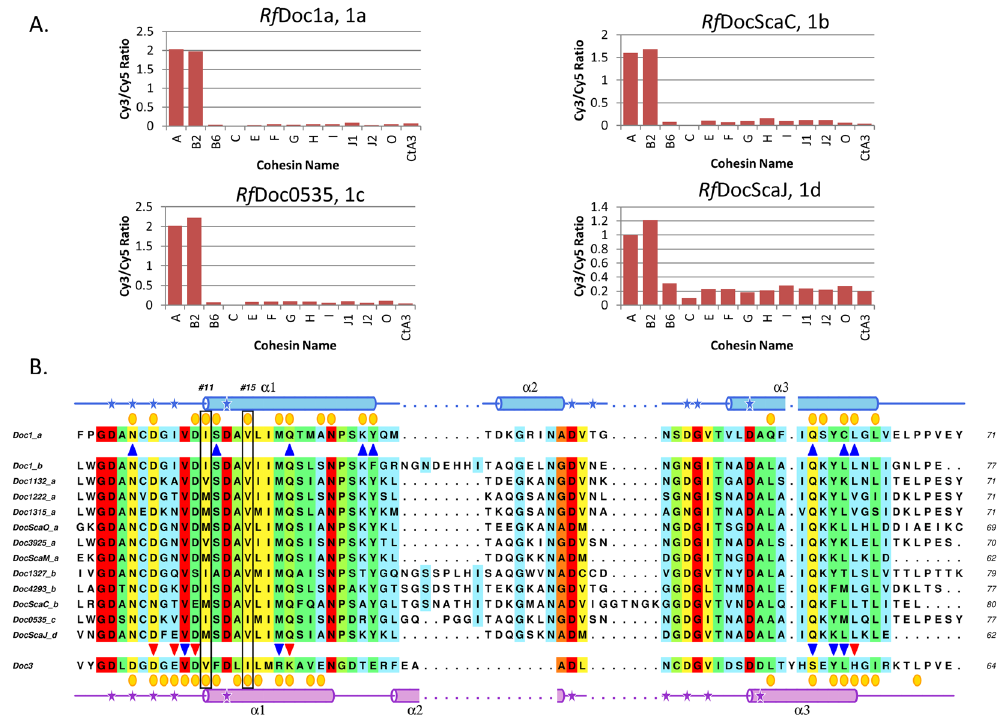
Figure 5. Coh-binding range and multiple sequence alignment of R . flavefaciens group 1 dockerins. ( A ) Results of Coh-Doc interactions using a cellulose microarray assay with XynDoc/CBM-Coh fusion protein pairs. Each bar graph represents the recognition profile of one dockerin from a different group 1 subgroup and 12 cohesins. The bar values correspond to the ratio between the measured Cy3 and Cy5 signals. Intensity values were calculated by Array Vision Evaluation 8.0 software and all data processing was made in Excel. ( B ) Multiple sequence alignment of R . flavefaciens group 1 Docs and group 3 Doc (Doc3). The primary sequence background is colored according to the ALSCRIPT Calcons convention, implemented in ALINE 41 : red, identical residues; orange to blue, lowering color-ramped scale of conservation. Above and below the alignment lies a cartoon representation of the secondary structure of Doc1a (blue color) and Doc3 (purple color), respectively (Coh- Doc complexes PDB codes: 5M2O and 5LXV, respectively). Also for these two Docs, the residues involved in molecular interactions with the Coh partner are represented as follows: blue triangle for hydrogen bonds, red triangle for salt bridges and yellow circles for hydrophobic contacts. Critical residues for Rf Doc1a/ Rf Doc1b Coh-binding are marked with a black box, highlighting the #11 and #15